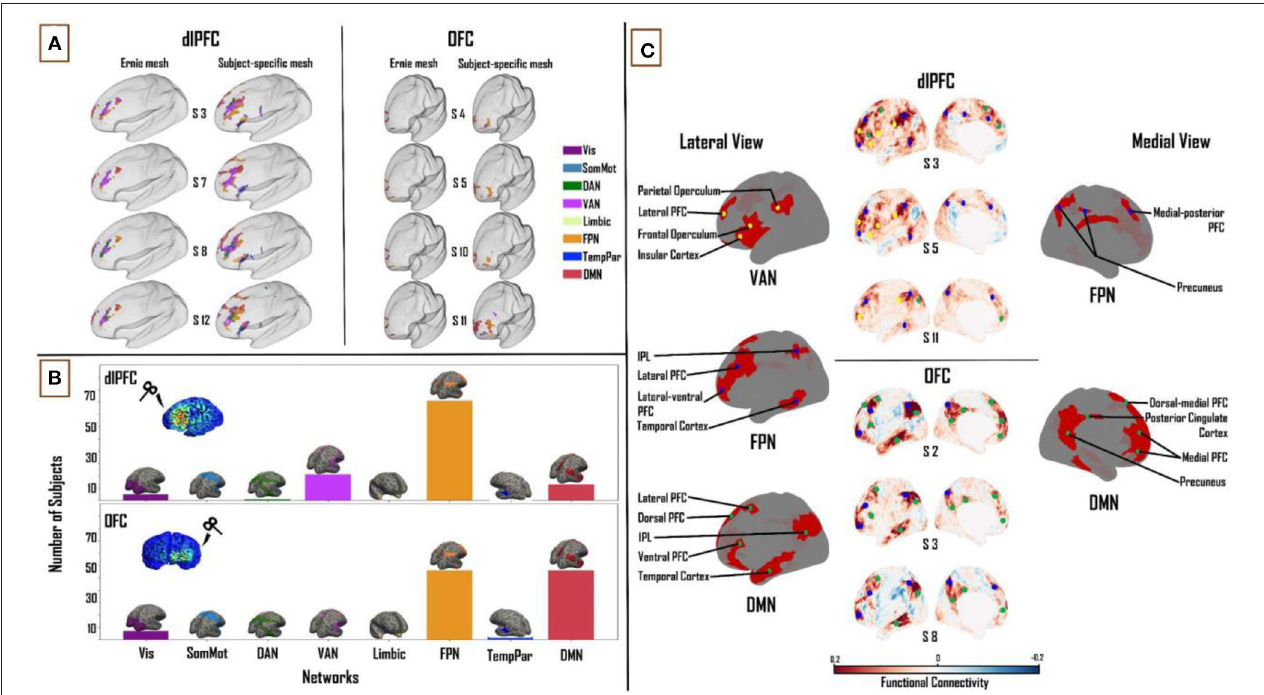
FIGURE 4 | Combined influence of individual cortical geometry and individual FC on TMS target connectivity. (A) Differences in patterns of FC between fixed (“ernie”) and subject-specific E-fields. (B) Like Figures 2 , 3 above, summary statistics of network engagement over all 121 subjects shows that the VAN, FPN, and DMN were the main networks engaged from the dlPFC [top]; while the FPN and DMN were the main networks engaged from the OFC [bottom] – Refer to Supplementary Figure 5 for a more detailed view of this panel. (C) Top: lateral and medial views of dlPFC FC maps in subjects 3, 5, and 11, highlighting the key regions that are functionally connected across the VAN, FPN, and DMN. These regions lie mainly in the frontal, parietal and temporal cortices. Bottom: lateral and medial views of OFC FC maps in subjects 2, 3, and 8, highlighting the key regions that are functionally connected across FPN and DMN. These regions lie mainly in medial-frontal, cingulate, and posterior parietal cortices. VAN, ventral attention network; FPN, frontoparietal network; DMN, default-mode network.